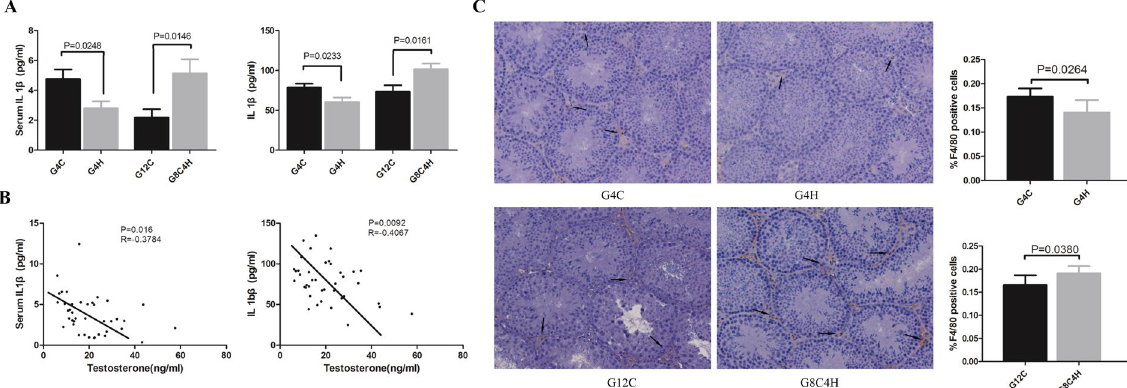
Figure 2. IL1 β is negatively correlated with testosterone and the number of macrophages in testes of mice-TIS and mice-TMS. ( A ) Serum and testis IL1 β (ELISA) in G4H and G8C4H groups compared with their control group. ( B ) Correlation analysis demonstrated that both serum (left) and testis (right) IL1 β levels were negatively correlated with testosterone in mice. ( C ) Immunohistochemical detection of the macrophage-specific antigen F4/80 (black arrows) in testes from each group of mice and comparison of the F4/80-positive cell ratio between G4H and G4C, G8C4H and G12C mice. Scale bars = 100 μ